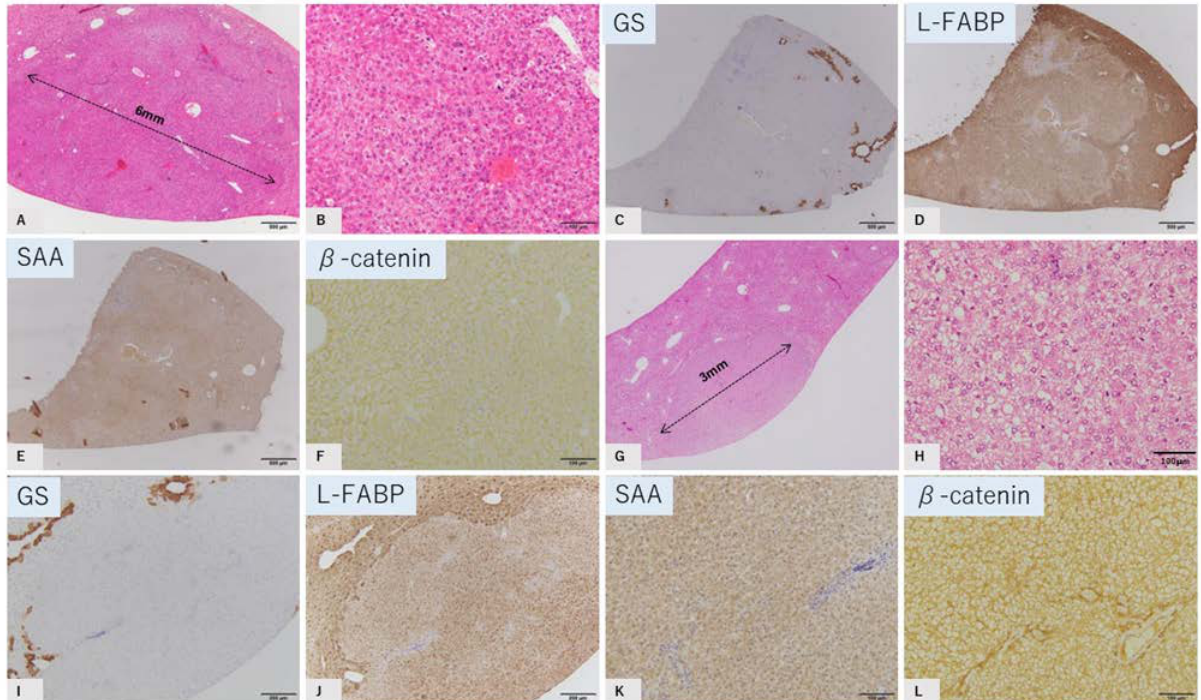
Figure 2. GS-negative tumor mimics of HNF1 a-inactivated HCA. Tumor 3, ( A – F ) and Tumor 5, ( G – L ). HE staining ( A , B , G , H ); immunostaining of GS ( C , I ), L-FABP ( D , J ), SAA ( E , K ), and b-catenin ( F , L ). Tumor shows a trabecular pattern of hepatocytes showing mild vacuolation. No capsule is observed. GS: negative, L-FABP: attenuated, SAA: no strong staining, b-catenin: membranous staining. Tumor diameter is 6 mm in tumor 3 ( A ), and 3 mm in tumor 5 ( G ) (scale: C – F , I – L , 500 μm; B , H , 100 μm).